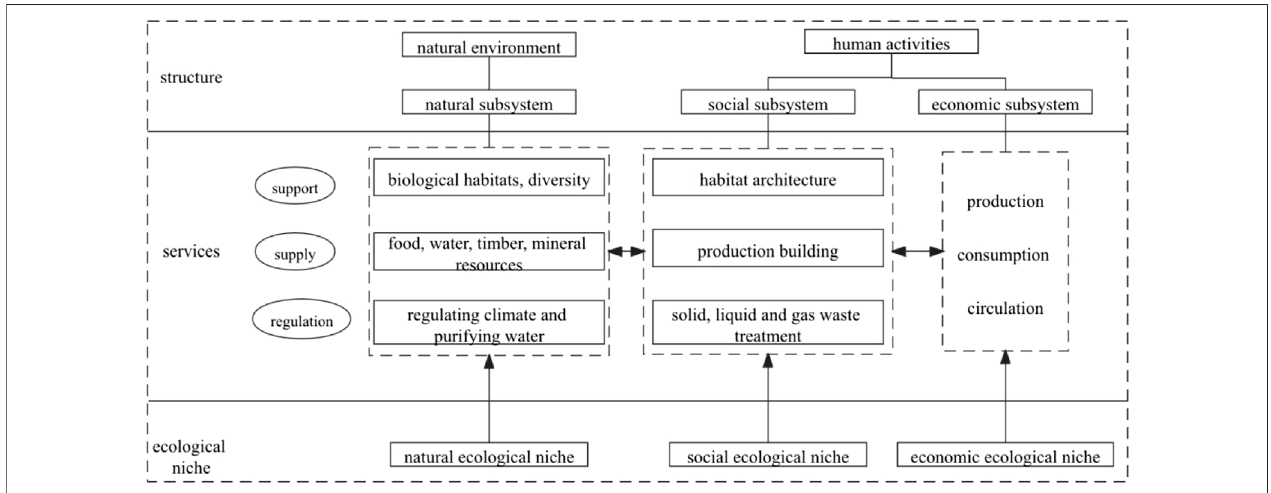
FIGURE 1 | Concept map of complex ecosystems.